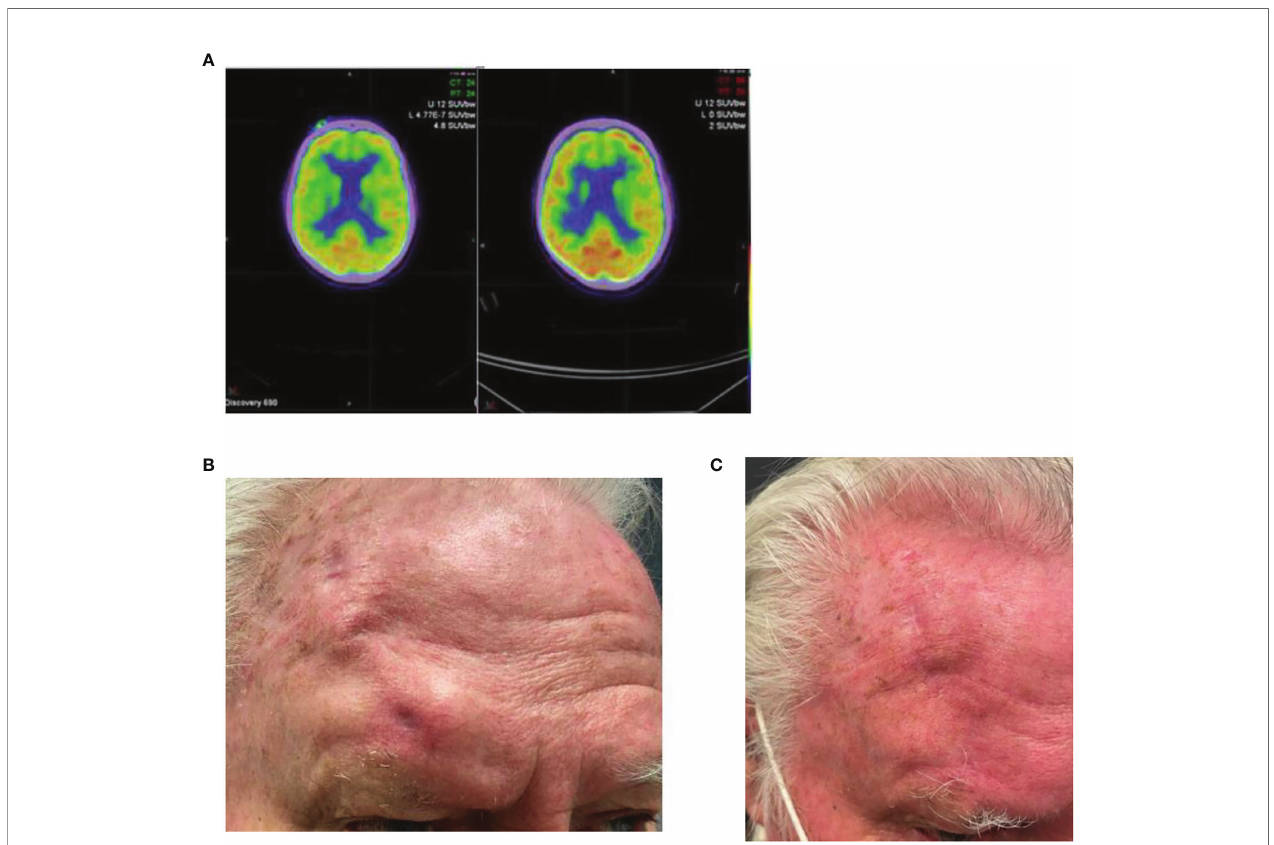
FIGURE 3 | (A) Baseline FDG-PET imaging demonstrating an avid right supraorbital cutaneous malignancy with a complete metabolic response seen on follow up FDG-PET post four cycles of cemiplimab 350 mg/3-weekly. (B) Baseline photo of the right supraorbital clinical mass. (C) Post 7 cycles of cemiplimab demonstrating complete